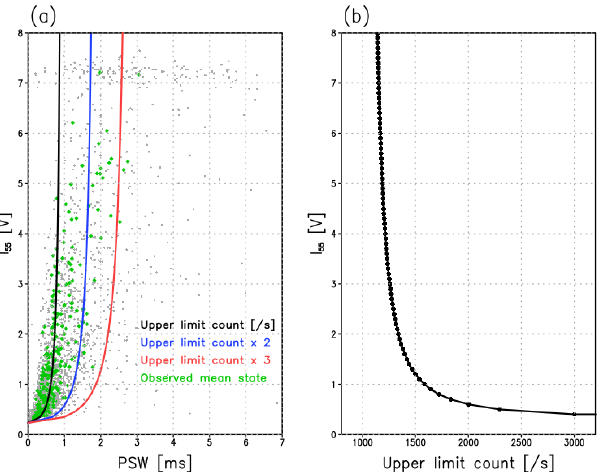
Figure 12. (a) Estimated relationship between PSW and I 55 based on the upper limit of countable particle number (a black line) in the case of PSW e = 1.0. Blue and red lines indicate the doubled and tripled situations from the normal upper limit count. Gray dots are the same plot in Fig. 6a. Green dots indicate the mean state for each second after applying the cutoff value of PSW (PSW c ). (b) Upper limit of countable particle number as a function of I 55 in case of PSW e =